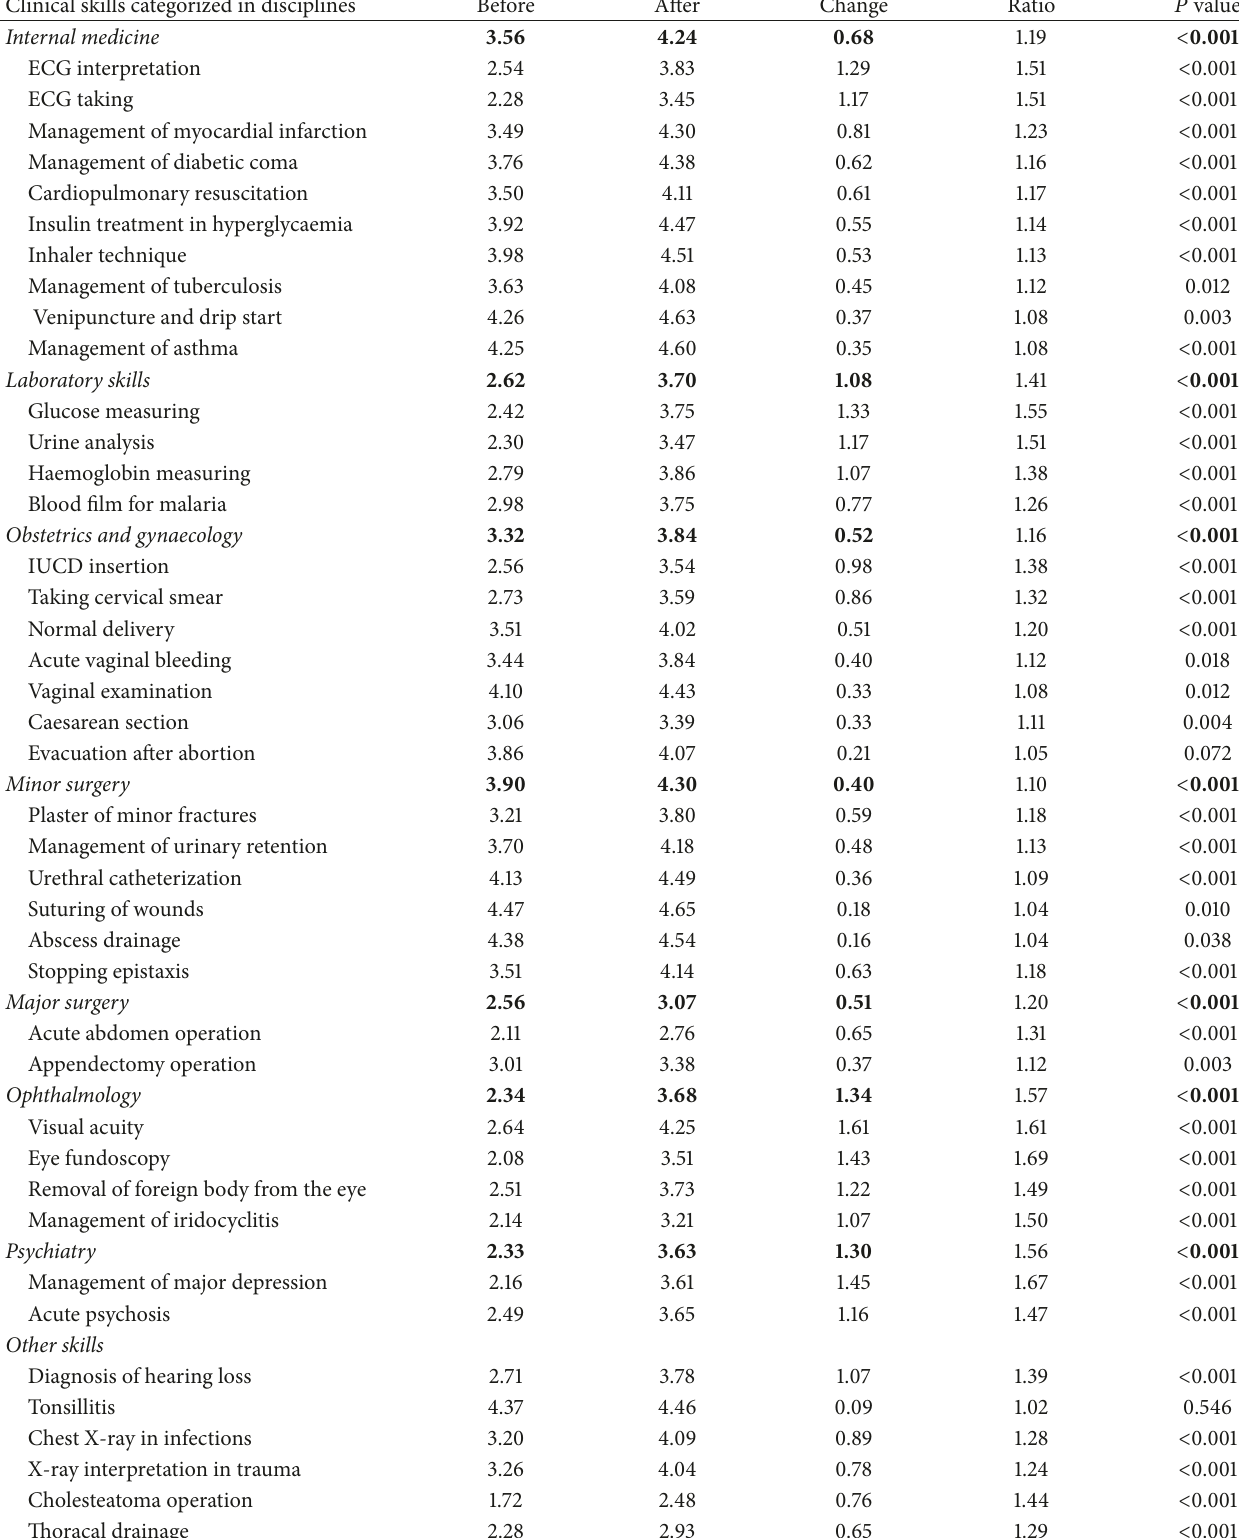
Table 1: Self-assessment in performing 46 clinical skills before and after the GFMP, Gezira state, Sudan ( 𝑁 = 108 ). Numbers represent means for each skill. Change is the absolute difference between the ”after” result and the ”before” result. Ratio is the relative change calculated by the ”after” result divided by the ”before”